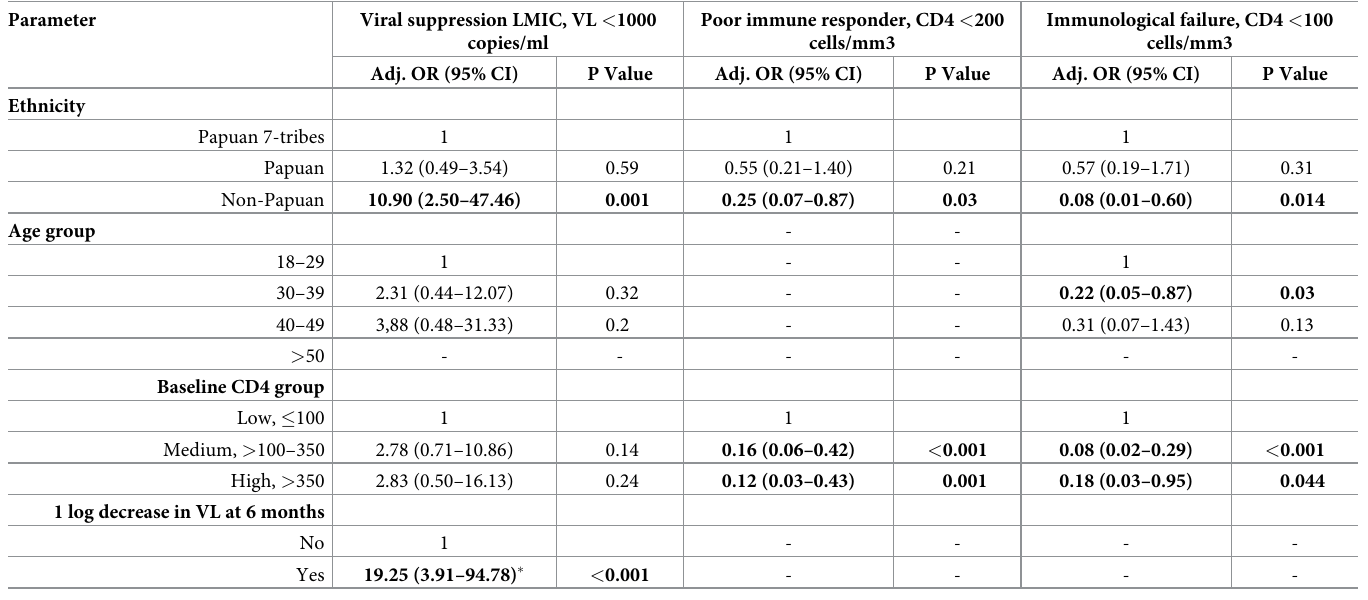
Table 3. Logistic regression (GEE) analysis of factors influencing HIV treatment outcomes at 6, 12 and 36 months using multivariate analysis comparisons across low, medium and high groups.